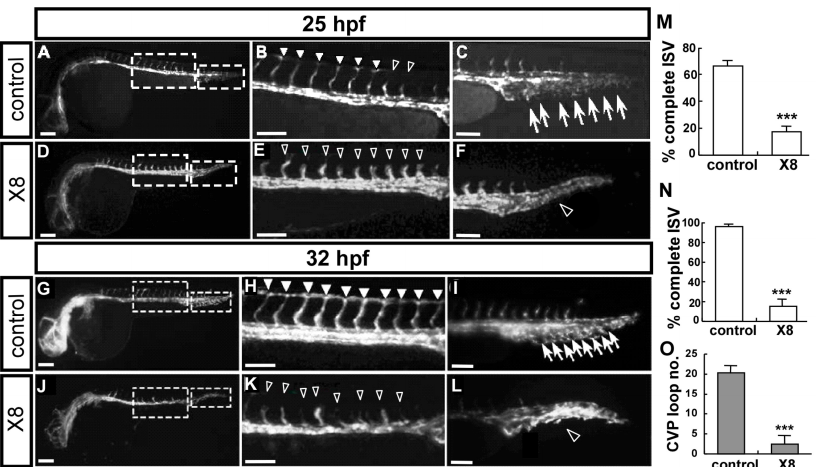
Figure 2. X8 treatment impairs vascular development during zebrafish embryogenesis. ( A – F ) Lateral view of X8-treated Tg(flk:eGFP) embryos at 25 hpf ( D ) showing decreased ISV growth to the top of the embryo (hollow arrowheads in ( E )) and decreased or a complete absence of angiogenic sprouting from the caudal vein (hollow arrowhead in ( F )) compared with those parameters in wild-type control embryos (( A ), arrowheads in ( B ), and arrows in ( C )). ( A , D ) Fluorescent images of whole larvae; ( B , E ) and ( C , F ) are enlargements of the truck and tail regions of ( A , D ). ( G – L ) At 32 hpf, in untreated control embryos, ISVs reached the DLAV (( G ) and arrowheads in ( H )), and the CVP formed honeycomb-like loop structures at the tail (( I ), arrows). Meanwhile, ISVs were stalled in mid-somite in X8-treated embryos (( J ) and hollow arrowheads in ( K )), and decreased endothelial cell sprouting and loop formation at the CVP (hollow arrowhead in ( L )) were observed. ( H , I ) are enlargements of the truck and tail regions of ( G ) and ( K , L ) are enlargements from ( G ). ( M ) Quantification of the percentage of complete ISV structures showed a 3.5-fold decrease in X8-treated fish at 25 hpf. ( N , O ) Quantification of the percentages of complete ISV and CVP structures in X8-treated fish at 32 hpf showed reductions of ~5.2-fold and ~6-fold, respectively (n = 25 for control and n = 27 for X8 samples). *** p < 0.0001 by unpaired Student’s t -test. Scale bars: 200 µ m in ( A , D , G , J ); 100 µ m in ( B , C , E , F , H , I , K , L ).